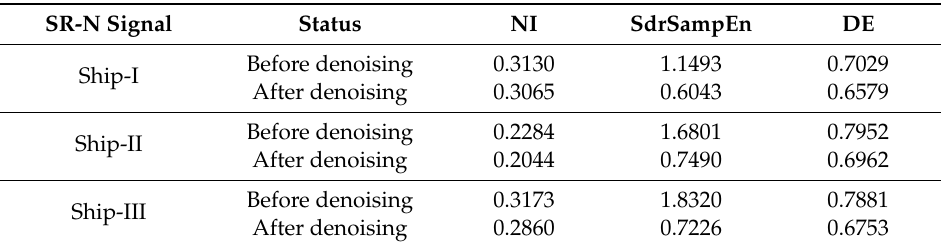
Table 5. Feature parameters before and after noise